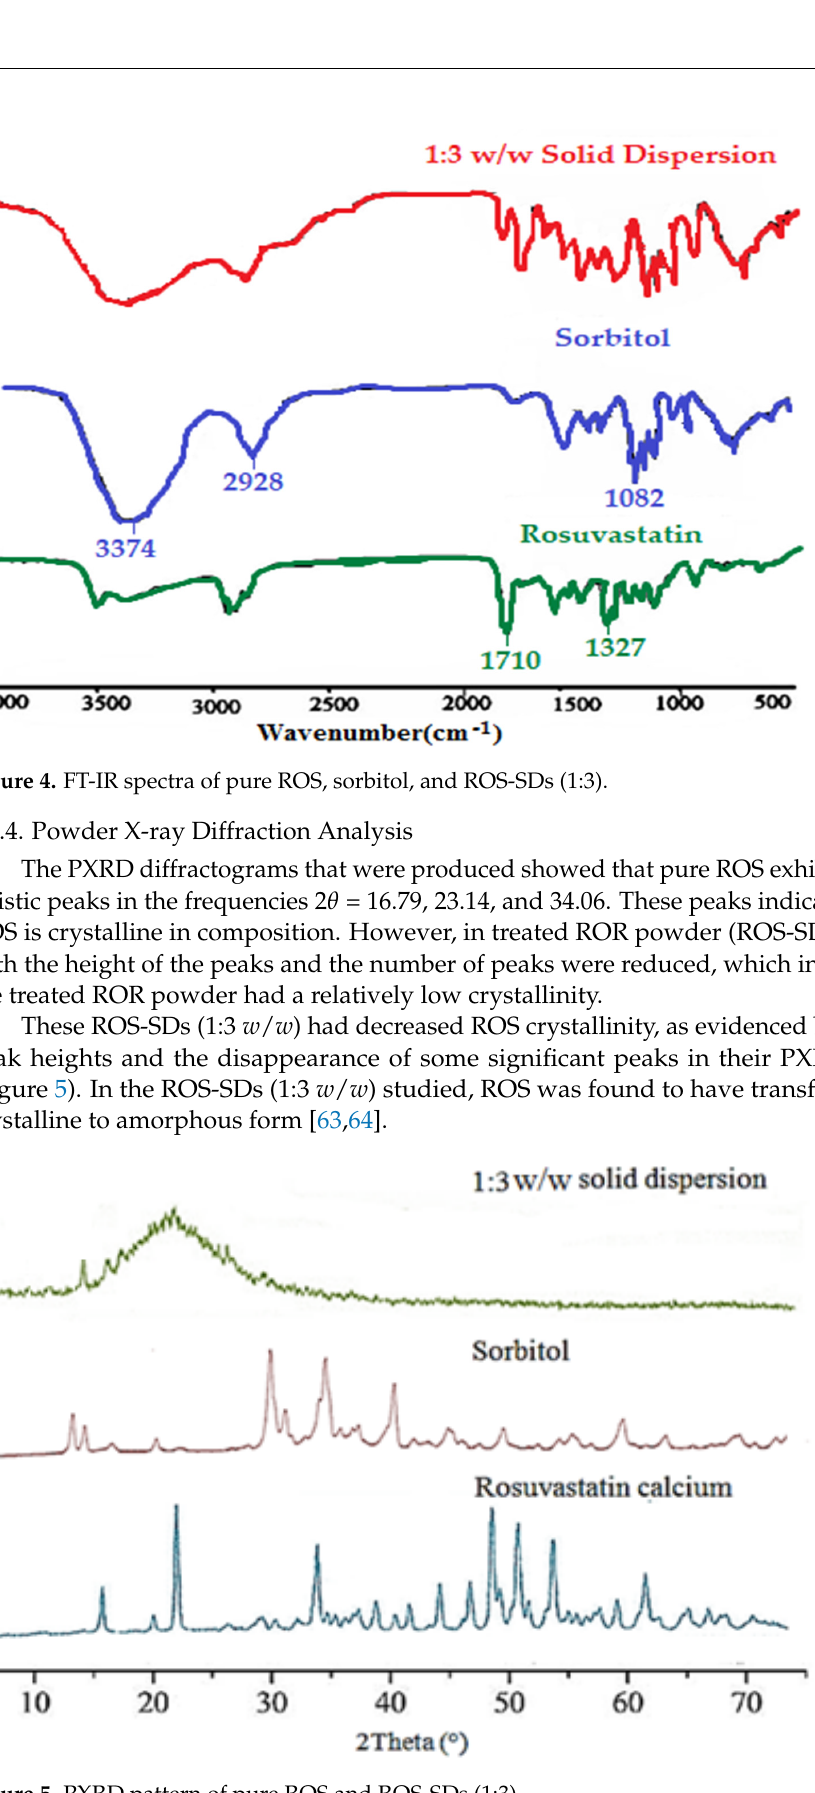
Figure 5. PXRD pattern of pure ROS and ROS-SDs (1:3).